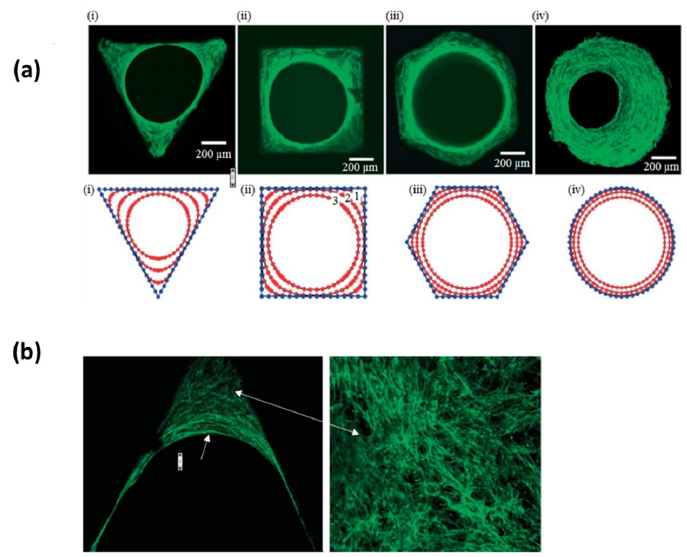
Figure 6. ( a ) Top images show osteoblasts seeded in four different HA plates with various geometries after 21 days (i–iii) and 30 days (iv) to images taken after 21 days of culture and (iv) at 30 days compared with numerical simulations at the bottom. ( b ) F-actin filaments (green) are more disordered in areas with high curvature (close to the edge of the triangle) whereas they are more aligned near the tissue/fluid interface (all images adapted from Rumpler et al. [154], Creative Commons Attribution License).